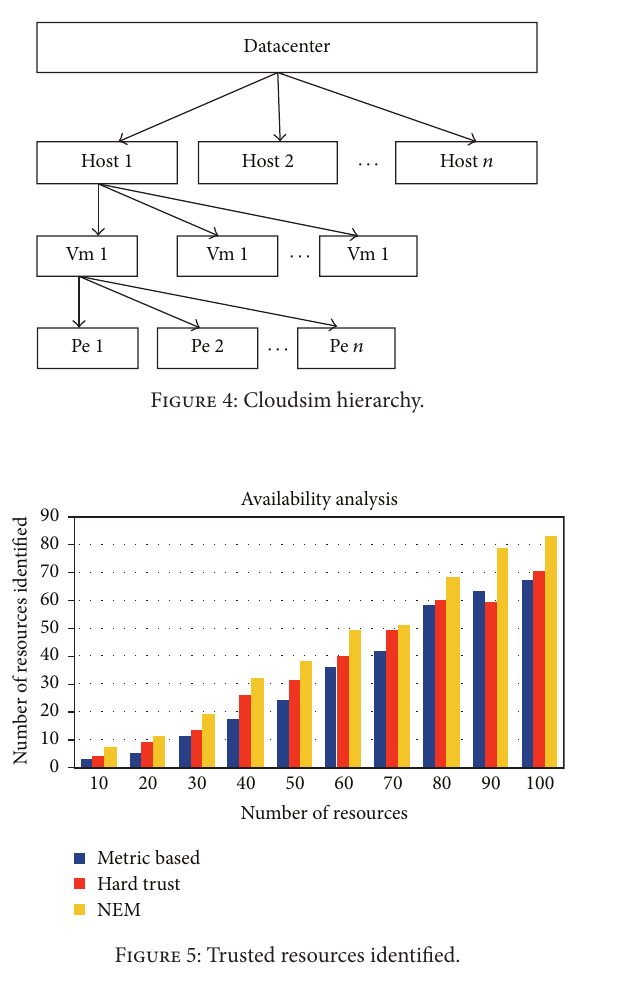
Figure 7: Time taken for trust